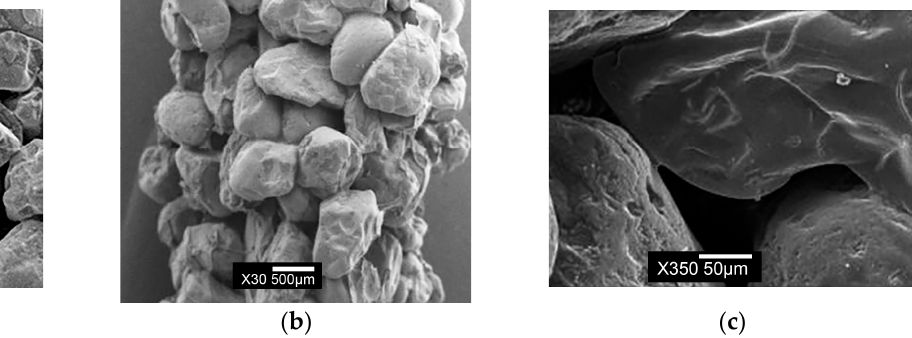
Figure 7. Micrographs outside the surface ( a ), edge of crust ( b ) and transverse fault ( c ) of the poly- mer-sand crust prepared with a PDADMAC–BSM formulation (W = 0.2).